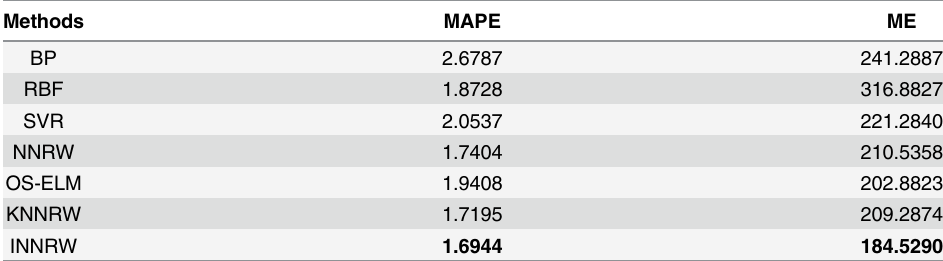
Table 4. Compared forecasting results.